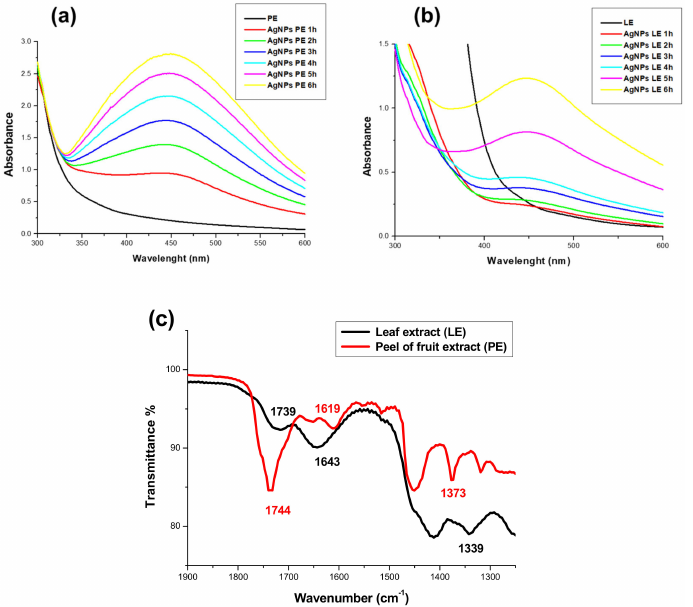
Figure 1. AgNPs-PE and AgNPs-LE characterization: UV-Vis spectra of AgNPs-PE ( a ) and AgNPs-LE ( b ) at different reaction times. FTIR spectrum ( c ) of leaf extracts (LE) and fruit peel extract (PE) of A.